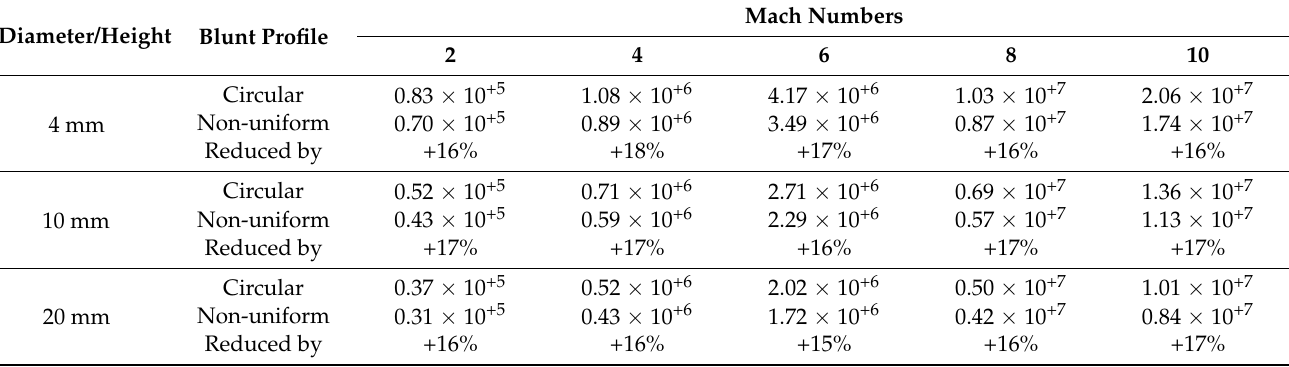
Table 3. Comparison of peak heat flux for various Mach numbers (unit: W/m 2 ).